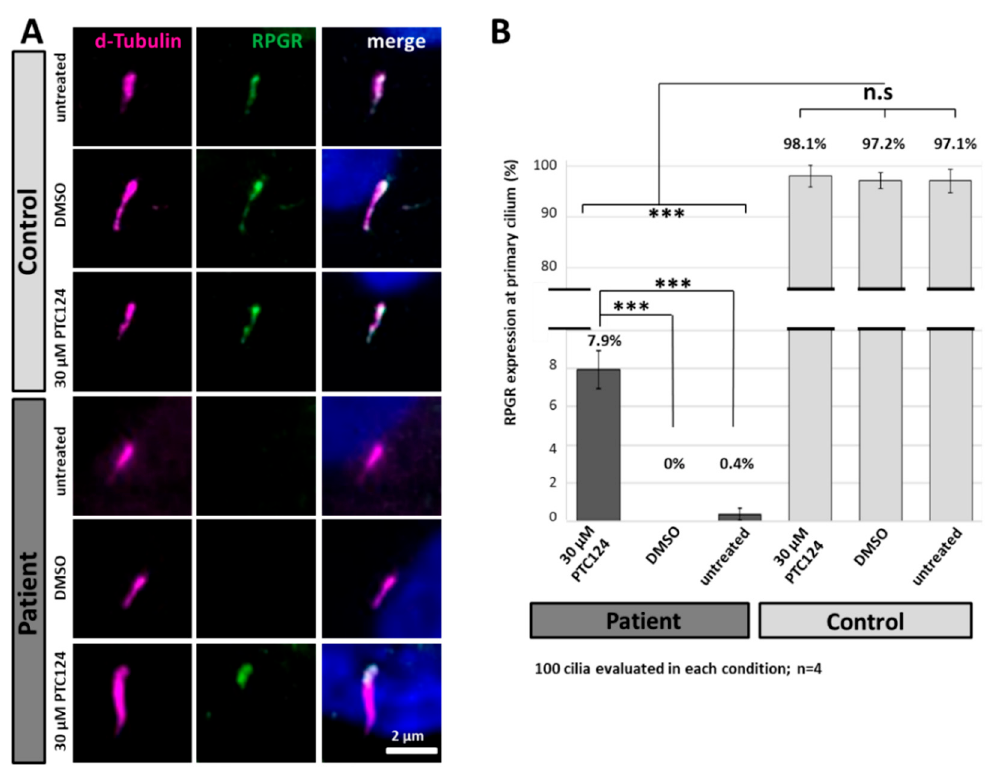
Figure 5. PTC124 treatment partially restores RPGR protein expression and localization in patient-derived fibroblasts. ( A ) Immunocytochemistry of the primary cilium (d-tubulin, magenta) and the subcellular localization of RPGR (green). Read-through therapy was applied using a single dose of 30 µ M PTC124. Control cell lines showed similar RPGR expression patterns in each condition. Neither DMSO nor PTC124 did influence the ciliary localisation of RPGR in control cells. Untreated and DMSO treated fibroblasts derived from the patient showed no RPGR at the primary cilium. PTC124 treatment restored RPGR localization at the primary cilium, predominantly detected at one end of the axoneme. Scale bar: 2 µm. ( B ) Quantification of RPGR signals at the primary cilium in the index patient confirmed differences between PTC124-treated and control conditions. Approximately 8% of the PTC124-treated patient-derived cells showed RPGR at the primary cilium. The PTC124 treatment showed no detectable influence in RPGR´s localization in the control cell lines. The analyses were reproduced in four independent replicates (n = 4). Error bars represent standard deviation. Asterisks: significant differences; n.s: non-significant, ***: p ≤ 0.001.